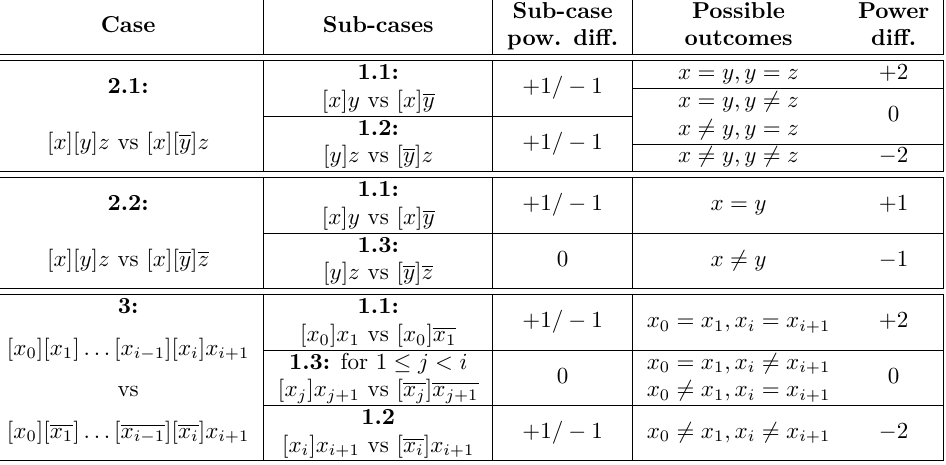
Table 1: Power consumption differences and relations of multiple register bits Sub-case Possible Power Case Sub-cases pow. diff. outcomes diff.